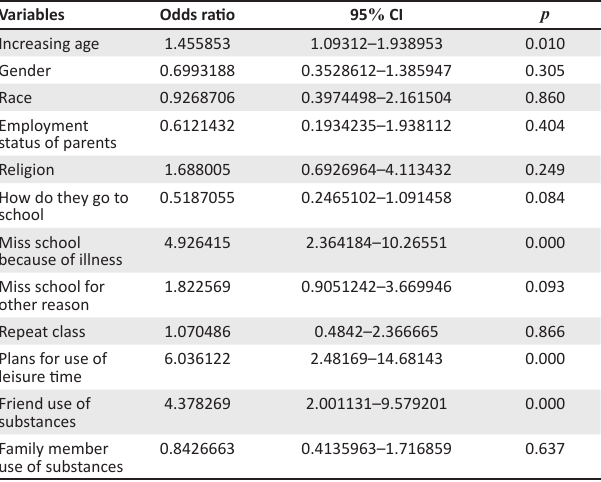
TABLE 7: Factors associated with substance abuse.